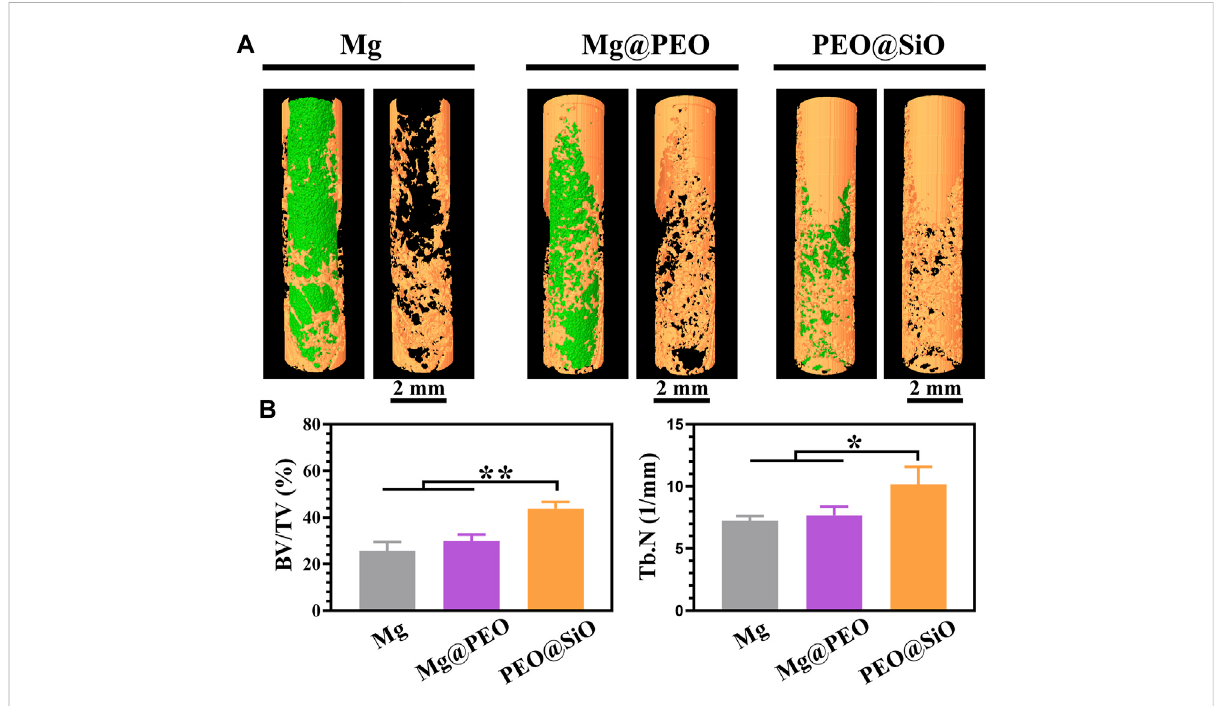
FIGURE 7 Micro-CTanalysisofbonefemurobtainedafterimplantationwithdifferentsamplesfor3 months: (A) 3D-reconstructionimagesoftheimplants and (B) corresponding quantitative analysis of the micro-CT data of BV/TV and Tb.N (* p < 0.05; ** p <